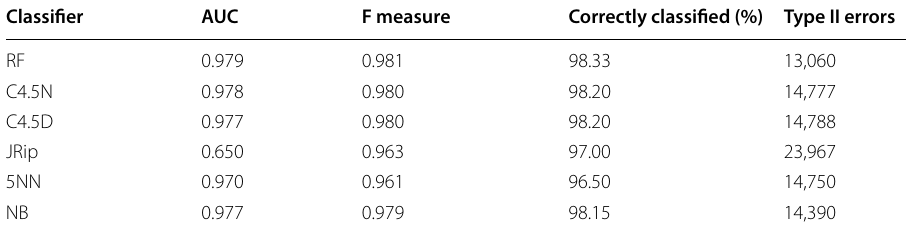
Table 7 CfsSubsetEval